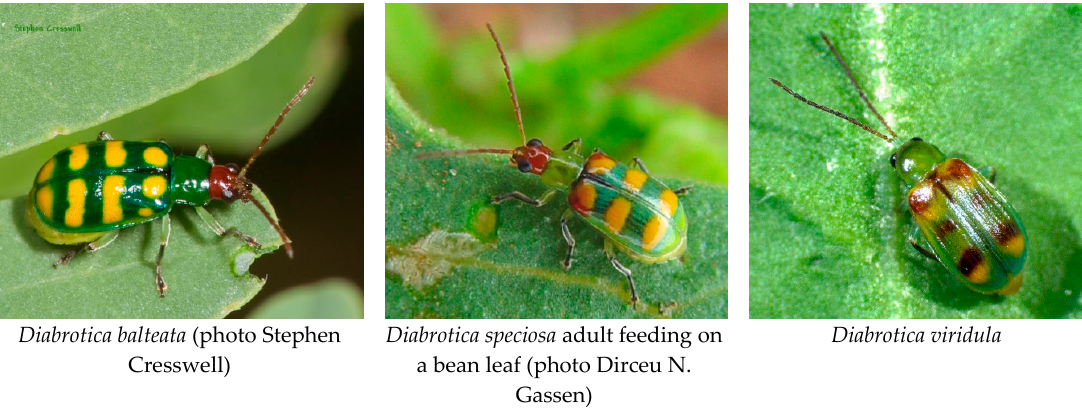
Figure 1. Photographs of the adult of the three species of pest Diabrotica from South America.